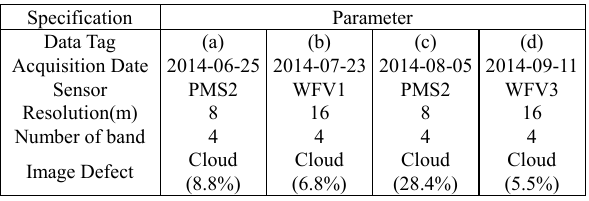
Table 1. Basic specifications of the multi-source